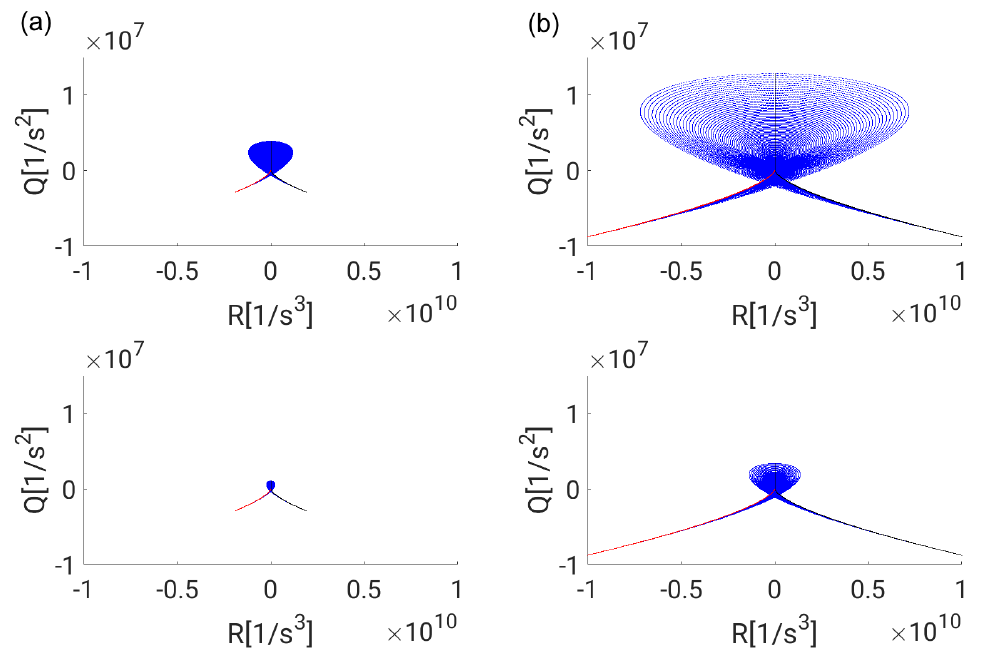
Figure 14. Scatter plots of the second invariant Q and the third invariant R in the bubble case ( ξ = 0.0182) with: ( a ) far-field boundary conditions on the left; and ( b ) near-field boundary conditions ( r W = 3 r B ) on the right. The interior phase is shown on the top and the exterior phase on the bottom, respectively.